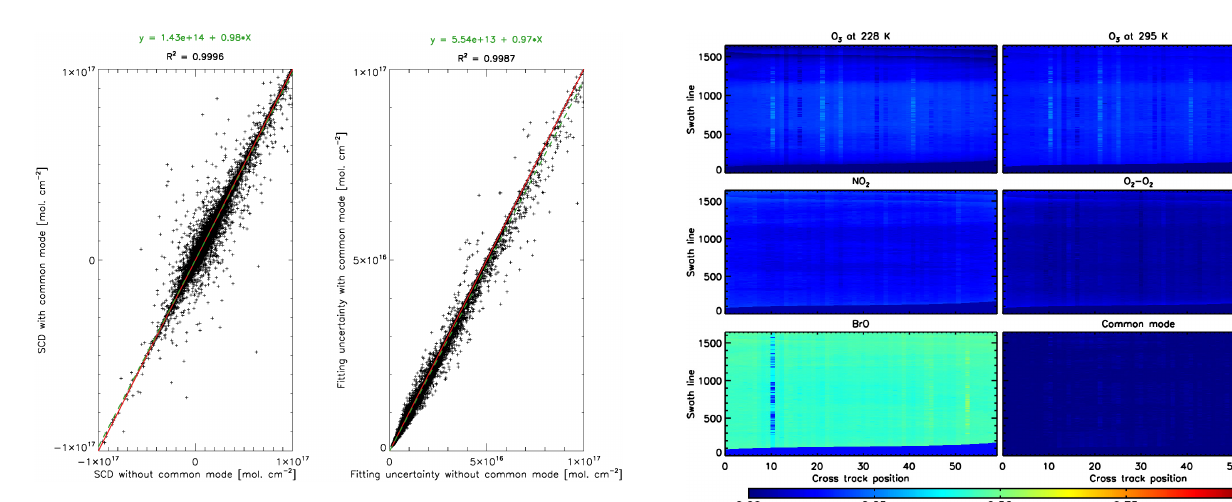
Figure 1. Fitting results of H 2 CO SCDs for OMI Orbit 11118 with and without common mode (17 August 2006 overpass over South America).